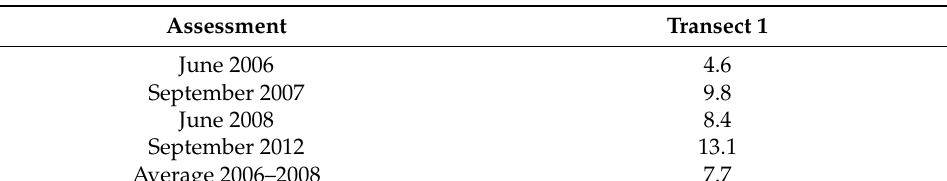
Table 1. Furthest distance (m) of dieback front movement (plant death) calculated from the closest dead plant (ignoring dead plants from previous years) in Transect 1 over a 7-year study. Trial